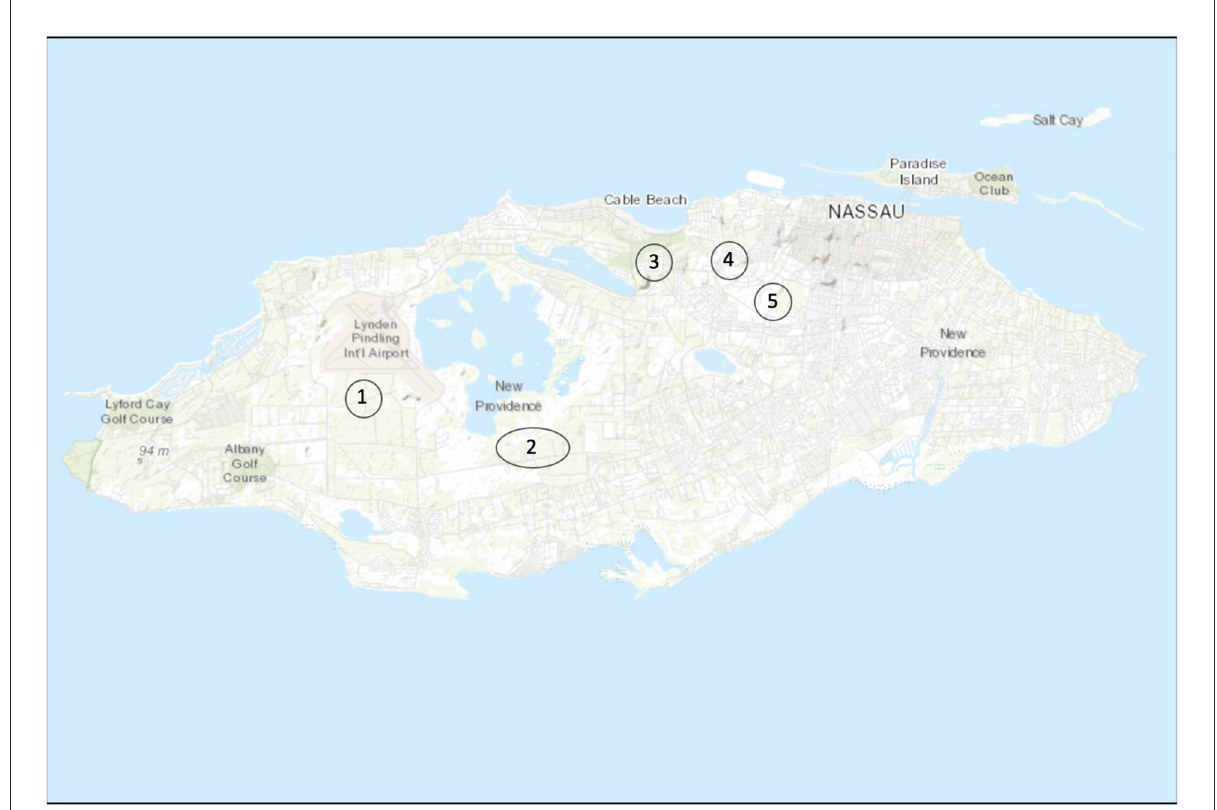
FIGURE2 General locations of the five major wellfields in New Providence that have served as sources for public water distributed by the government. The wellfields include (1) Windsor Wellfield, (2) Southwest Waterworks, (3) Prospect Waterworks, (4) Perpalls Waterworks, and (5) Blue Hills